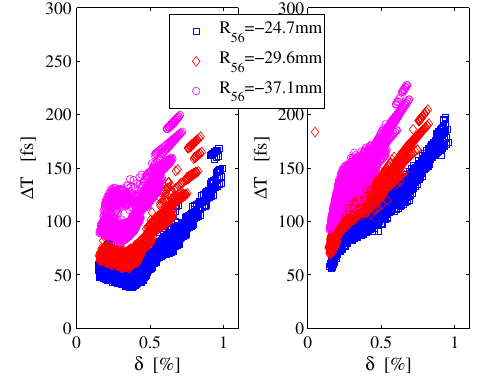
FIG. 8. Working points for different R 56 of BC2. The tail bunch is under (left) and over (right) compression, respectively. The peak current requirement is 3 – 5 kA of the core beam.